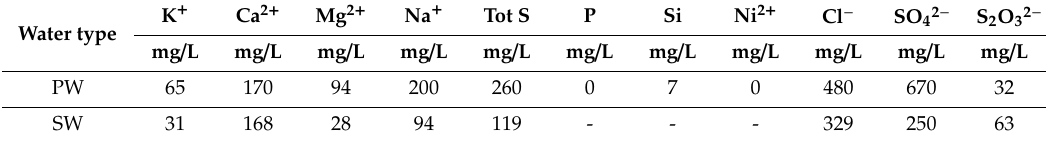
Table 3. Composition of the process water and the synthetic water that was used as the control